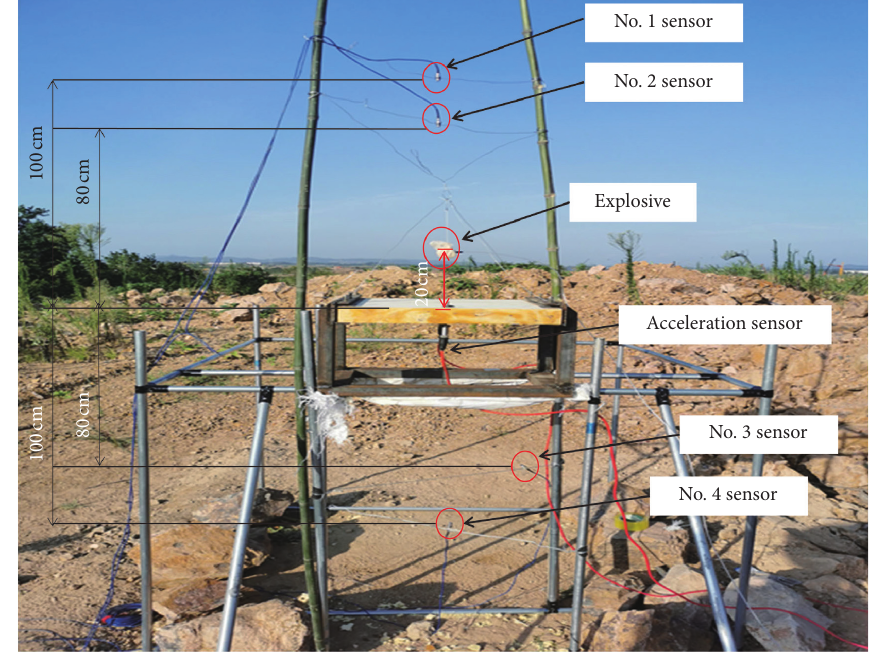
Figure 4: Experiment